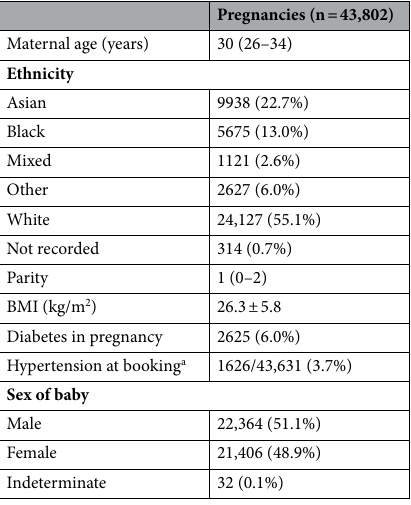
Table 1. Demographic data for included pregnancies. Data are presented as median (interquartile range), mean ± standard deviation, or number (percentage) as appropriate for data type and distribution. a 171 pregnancies did not have a blood pressure measurement recorded at